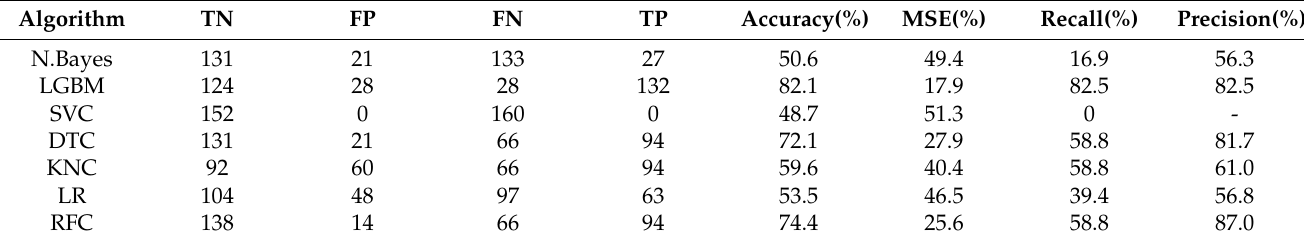
Table 8. The performance results using the first eight channels of EEG signals with machine learning classification